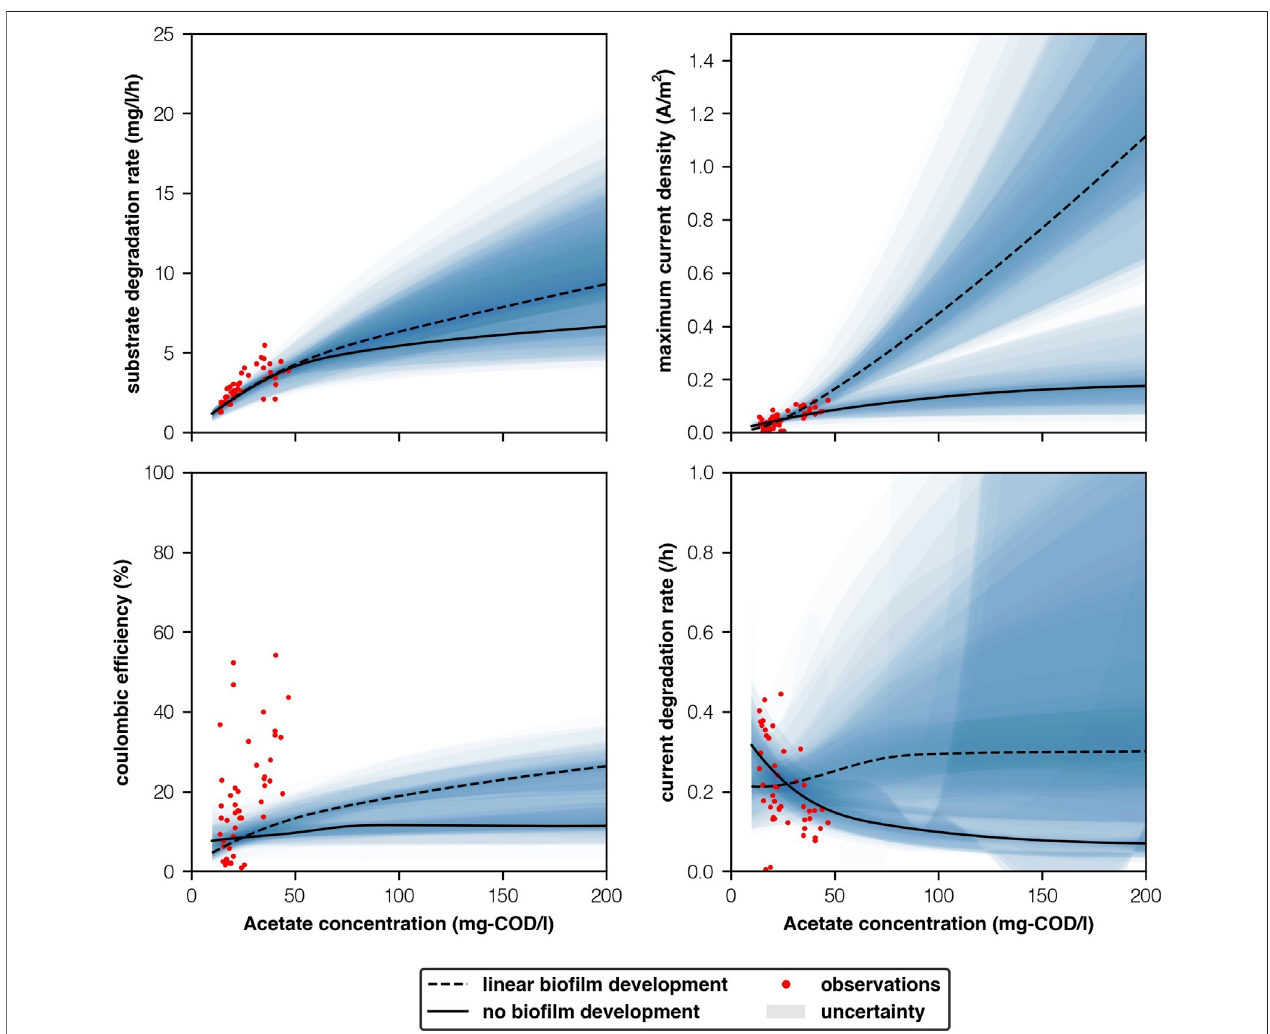
FIGURE 6 | Empirically observed parameters vs model predictions with respect to acetate concentration (mg-COD/l).